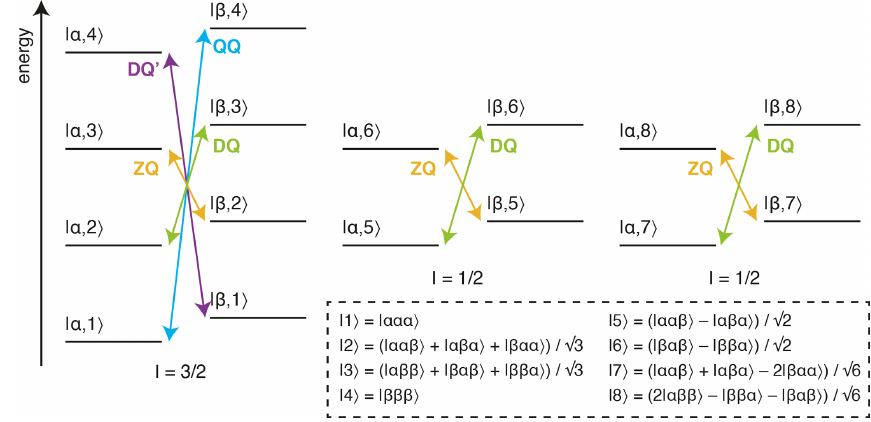
Figure 1. Energy level diagram for an isolated 13 CH 3 spin system. The multiple quantum transitions analysed in this work are indicated with arrows. Energy levels are indexed | C , H (cid:105) according to 13 C and 1 H spin states, where symmetrised combinations of 1 H spins are indicated in the inset box (Tugarinov and Kay,